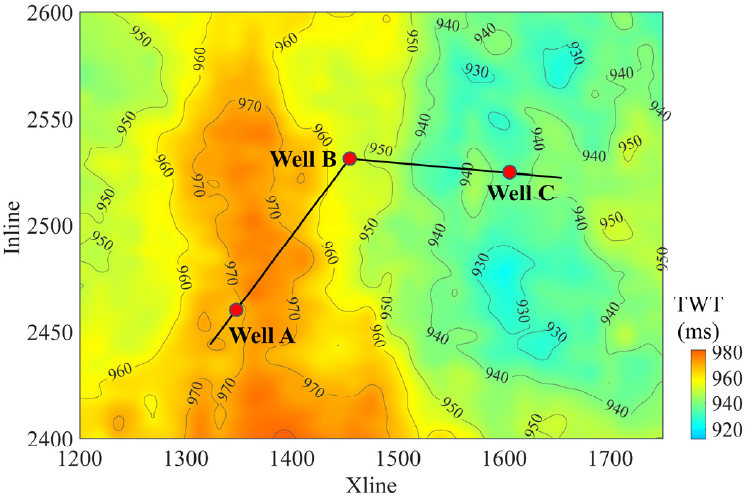
Figure 4. The two-way travel time for the target tight sandstones. Red dots indicate the locations of wells A, B, and C.